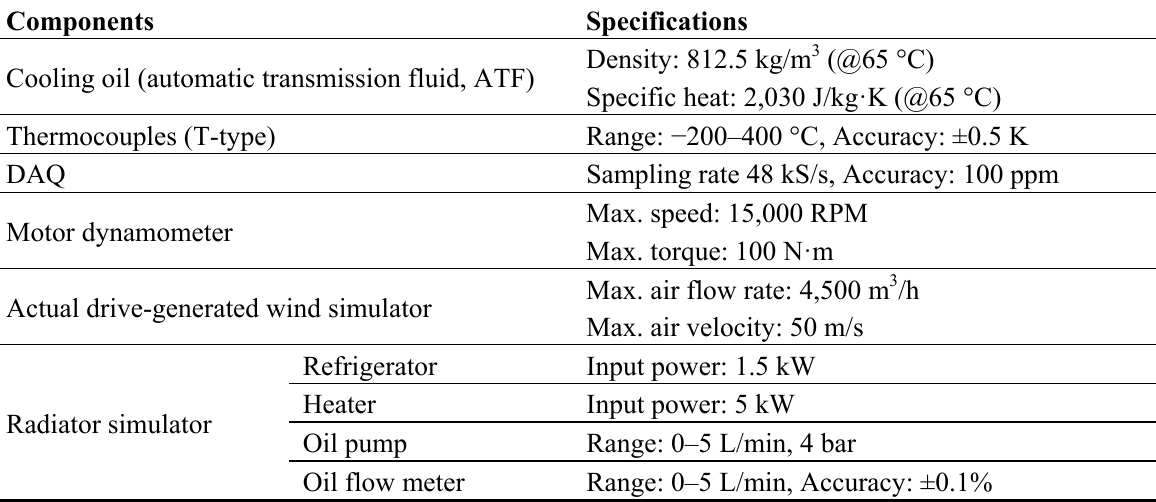
Table 2. Specifications of the experimental apparatus.